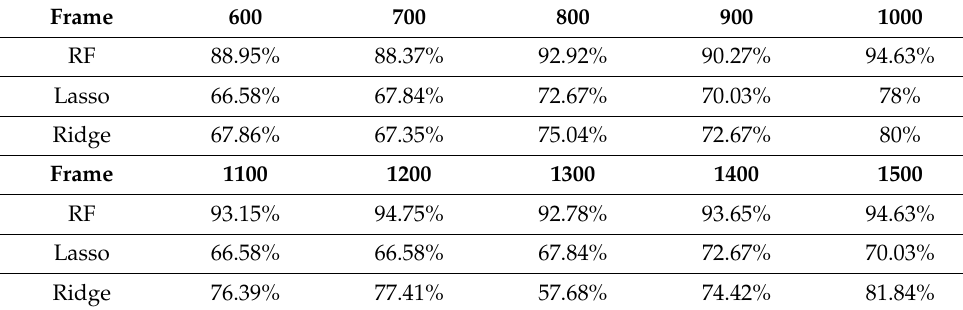
Table 2. Accuracy of different lengths of SMI signals for the measurement of A and f